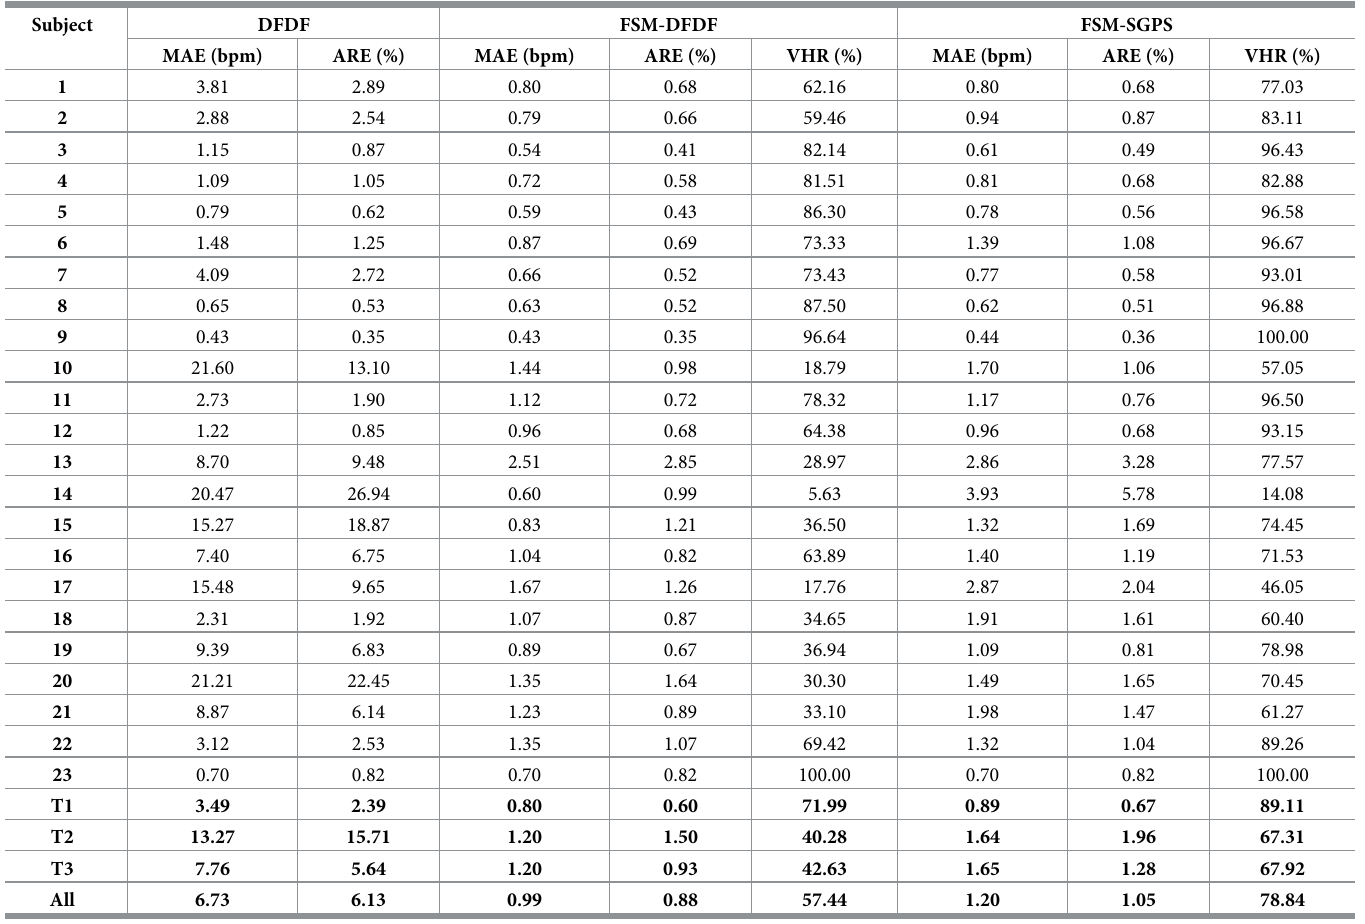
Table 3. Performance comparison of the DFDF, FSM-DFDF, and FSM-SGPS HR estimation methods.